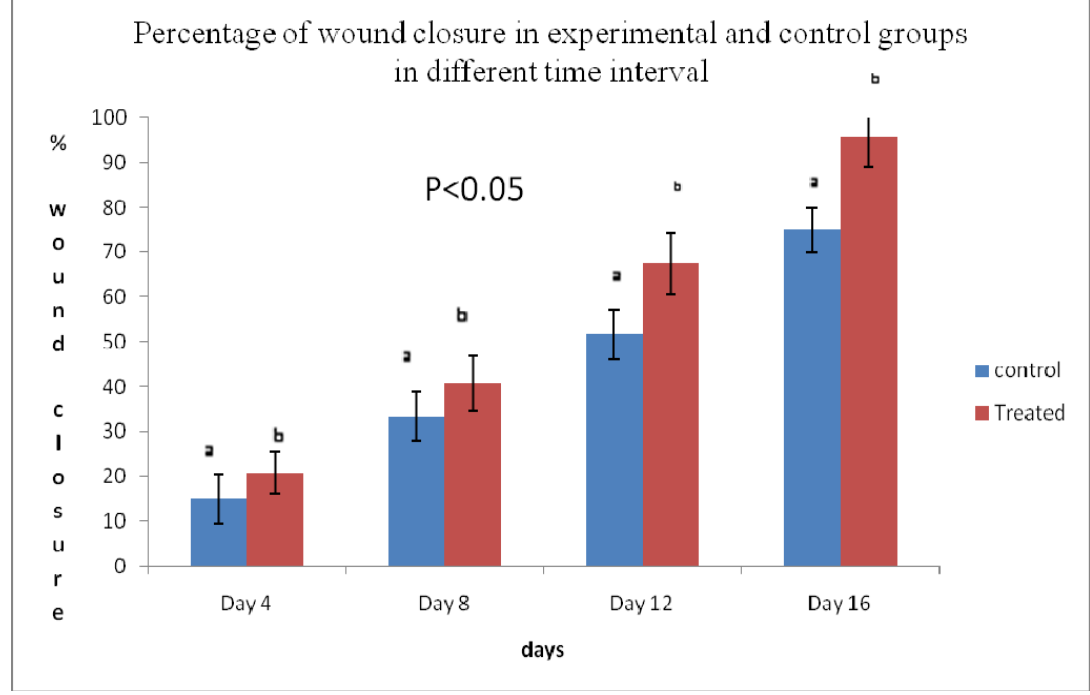
Figure 2. Percentage wound closure in the control and treated groups in different time intervals ( n = 8). Results are presented as mean ± SD.